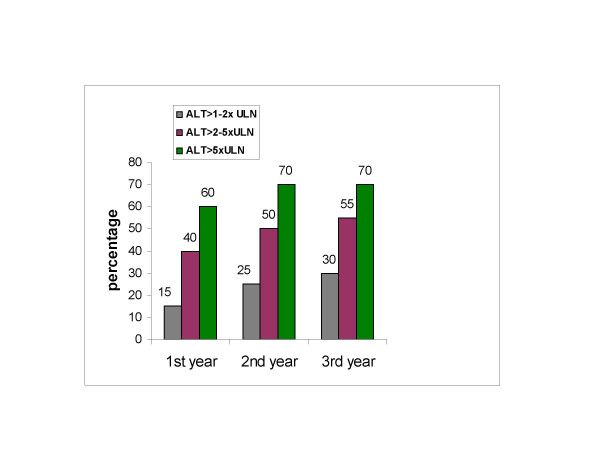
HBeAg Seroconversion Year wise According to Baseline ALT.